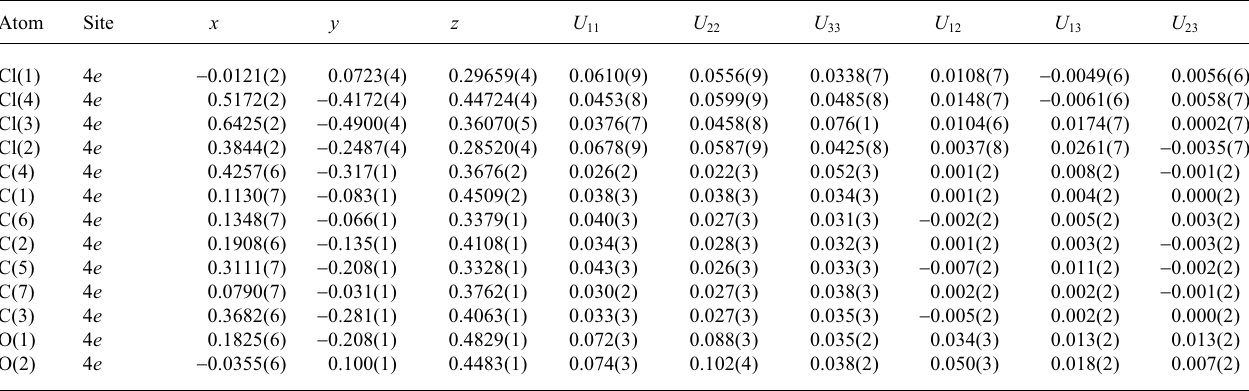
Table 3. Atomic coordinates and displacement parameters (in Å 2 )